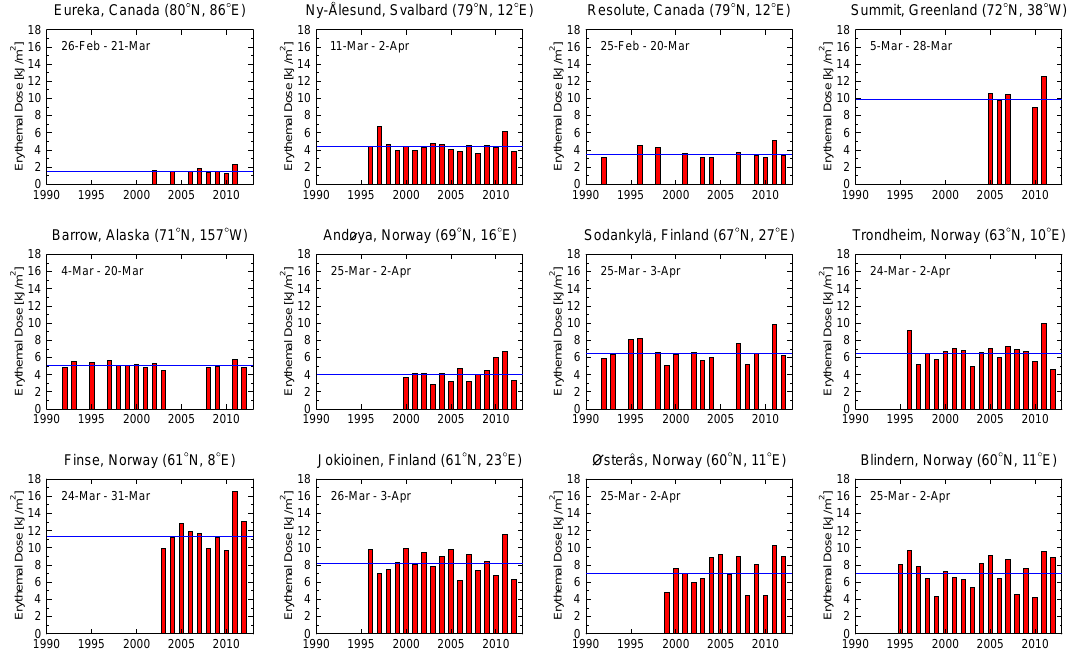
Fig. 6. Cumulative erythemal dose (CED) for the periods indicated in the top left corner of each panel. A CED of 10 kJ/m 2 is equivalent to 100 “standard erythemal doses” (SED) (Diffey et al., 1997). The average climatological dose for this period is indicated by a blue line. Data gaps prevented the calculation of an accurate dose at some sites and for some years. Data for Alert are not shown because of data gaps in